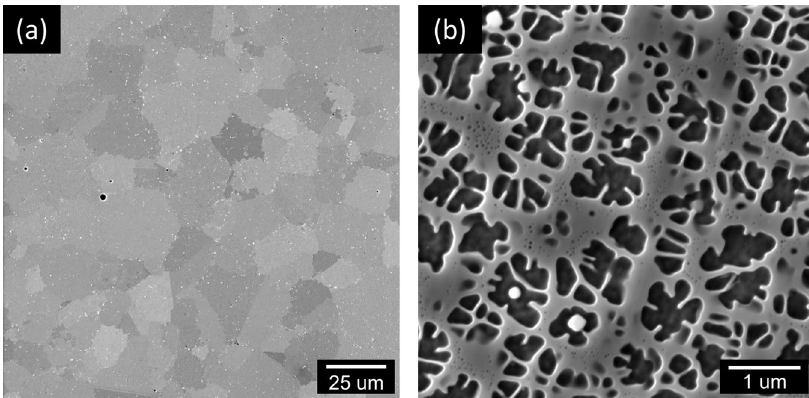
Fig. 1 Micrographs of grain and precipitate structure in TSNA-1. a SEM micrograph of TSNA-1 post heat treatment (1190 °C solution). b The γ / γ ʹ microstructure from a γ ʹ -etched specimen in SEM using a secondary detector after aging.